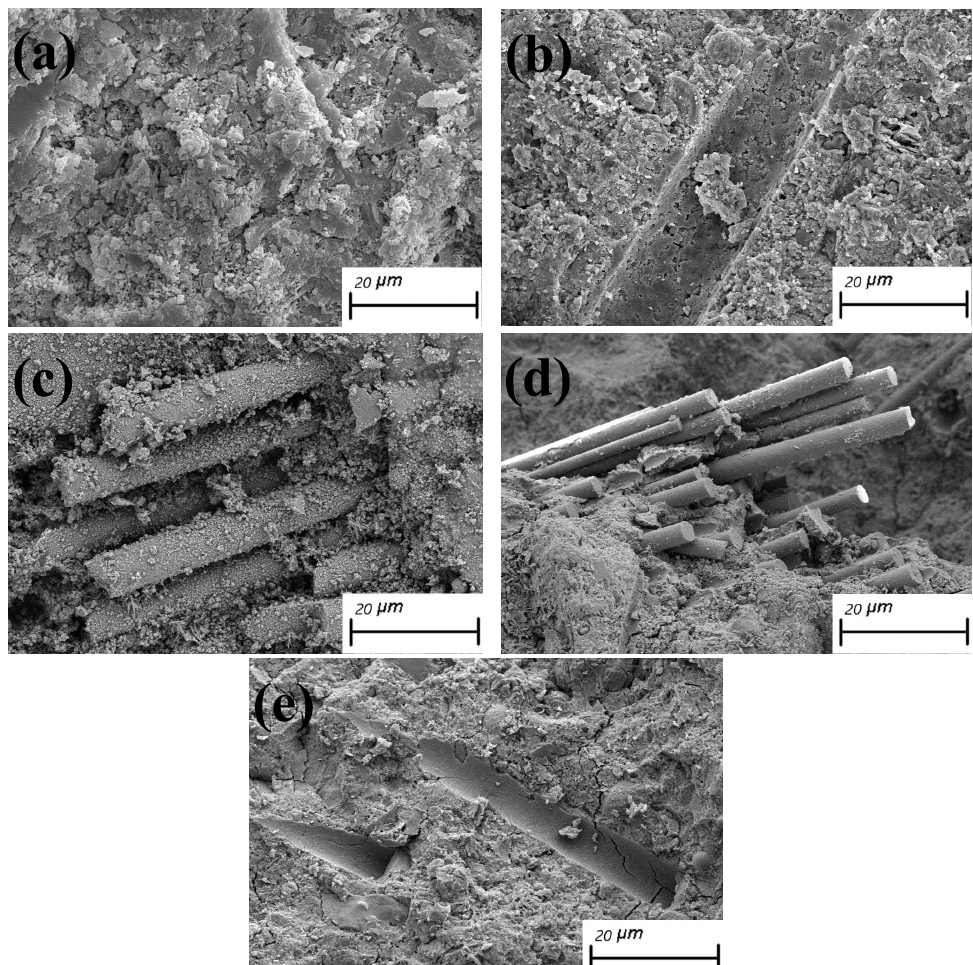
Figure 6. SEM images of five concrete: ( a ) OPC ( b ) S1B0.1 ( c ) S1B0.2 ( d ) S2B0.1 ( e ) S2B0.2.